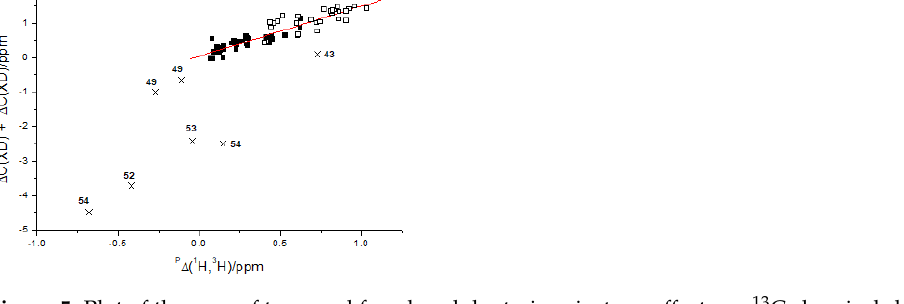
Figure 5. Plot of the sum of two- and four-bond deuterium isotope effects on 13 C chemical shifts vs. primary tritium isotope effects. Taken from Ref. [22], with permission from John Wiley and Sons.